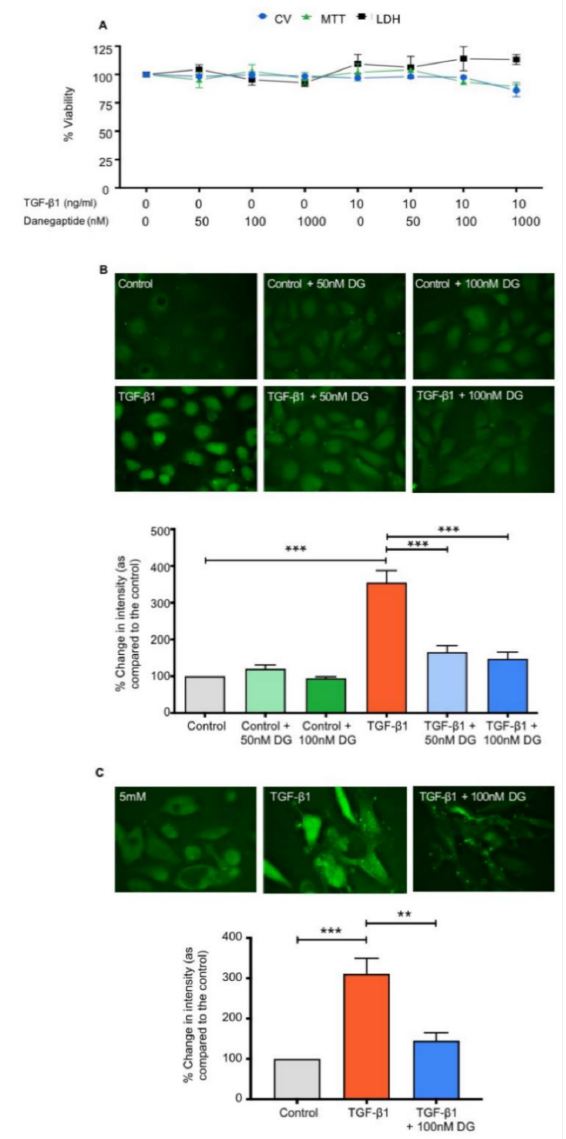
Figure 1. Danegaptide prevents TGF β 1-evoked increases in hemichannel-mediated dye uptake. In panel ( A ), human kidney 2 (HK2) cells were cultured in low glucose (5 mM) ± TGF β 1 (10 ng/mL) ± danegaptide (50, 100 and 1000 nM) for 48 h and cell viability assessed. Results are presented as the mean ± SEM ( n = 3). Incubation with TGF β 1 (10 ng/mL ± danegaptide (50–1000 nM)) did not alter 3-(4,5-dimethylthiazol-2-yl)-2,5-diphenyltetrazolium bromide (MTT) uptake, lactate dehydrogenase (LDH) release or crystal violet (CV) staining. In panels ( B ) and ( C ), carboxyfluorescein dye uptake was used to assess hemichannel activity in HK2 cells and human proximal tubule epithelial cells (hPTECs), with the degree of dye loading being directly proportional to opening. Cells were cultured in low glucose (5 mM) ± TGF β 1 (10 ng/mL) ± danegaptide (50 or 100 nM) for 48 h. Danegaptide prevented TGF β 1-evoked increases in carboxyfluorescein dye uptake in HK2 cells (panel ( B )) and hPTECs (panel ( C )). Minimal dye loading occurred in control cells, whilst dye loading significantly increased in cells treated with TGF β 1. Addition of danegaptide (50 or 100 nM) reduced dye uptake, returning the fluorescence intensity to control levels. Intensity is expressed as a percentage compared to low-glucose controls and is representative of 3 separate experiments. Data are presented as the mean ± SEM ( n = 3), with key significances indicated (** p < 0.01, *** p < 0.001; one-way ANOVA and Tukey’s